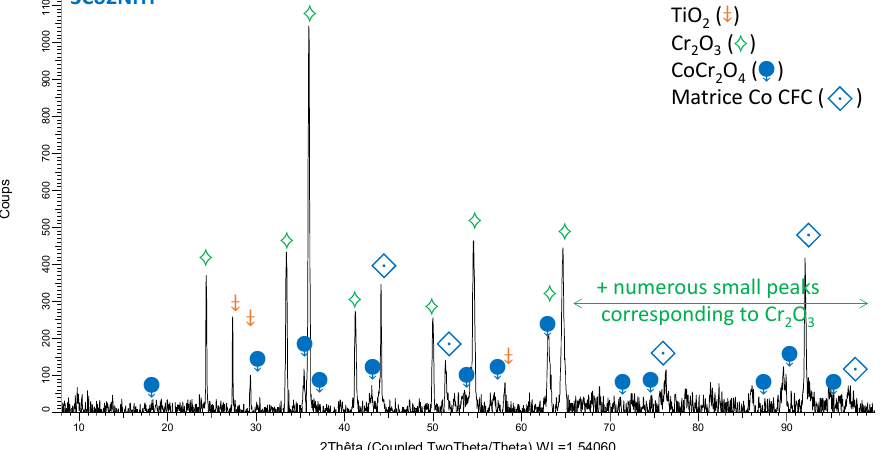
Figure 4. Diffractogram acquired on one side of the oxidized 3Co2NiTi sample.